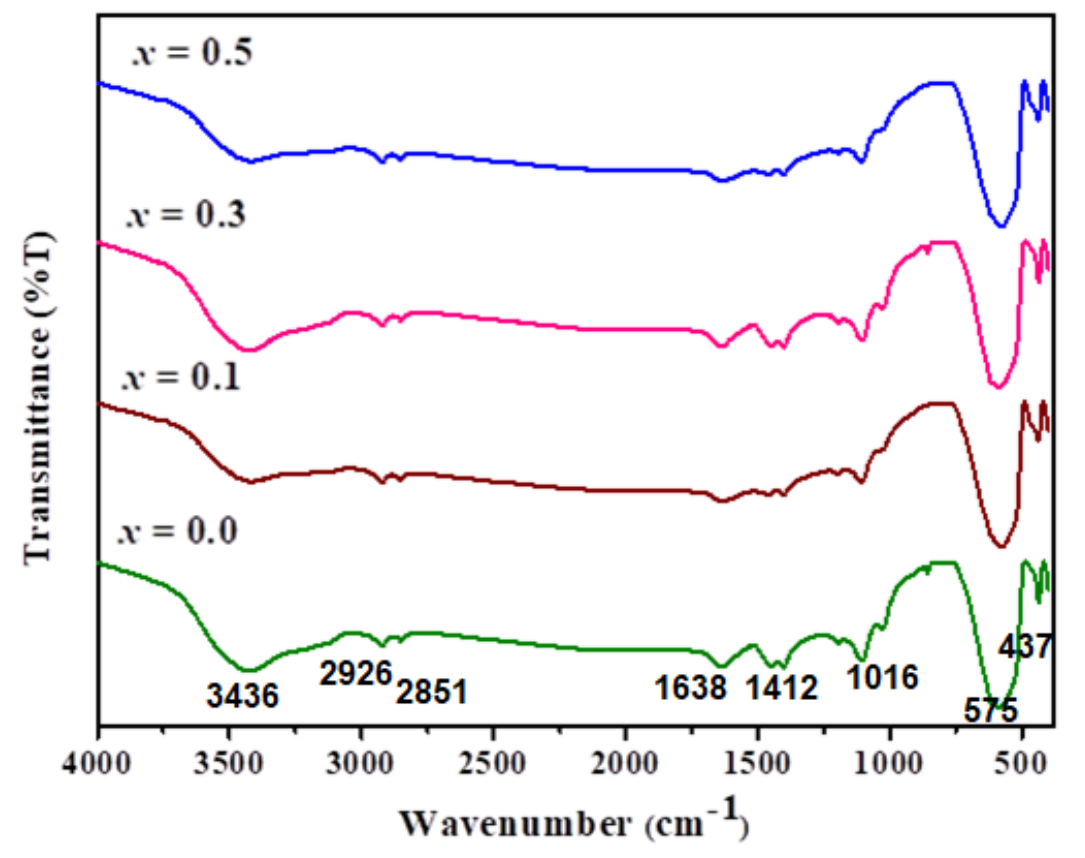
Figure 4. FT-IR spectra of spinel MnCe x Fe 2 − x O 4 (x = 0.0, 0.1, 0.3 and 0.5) NCs.